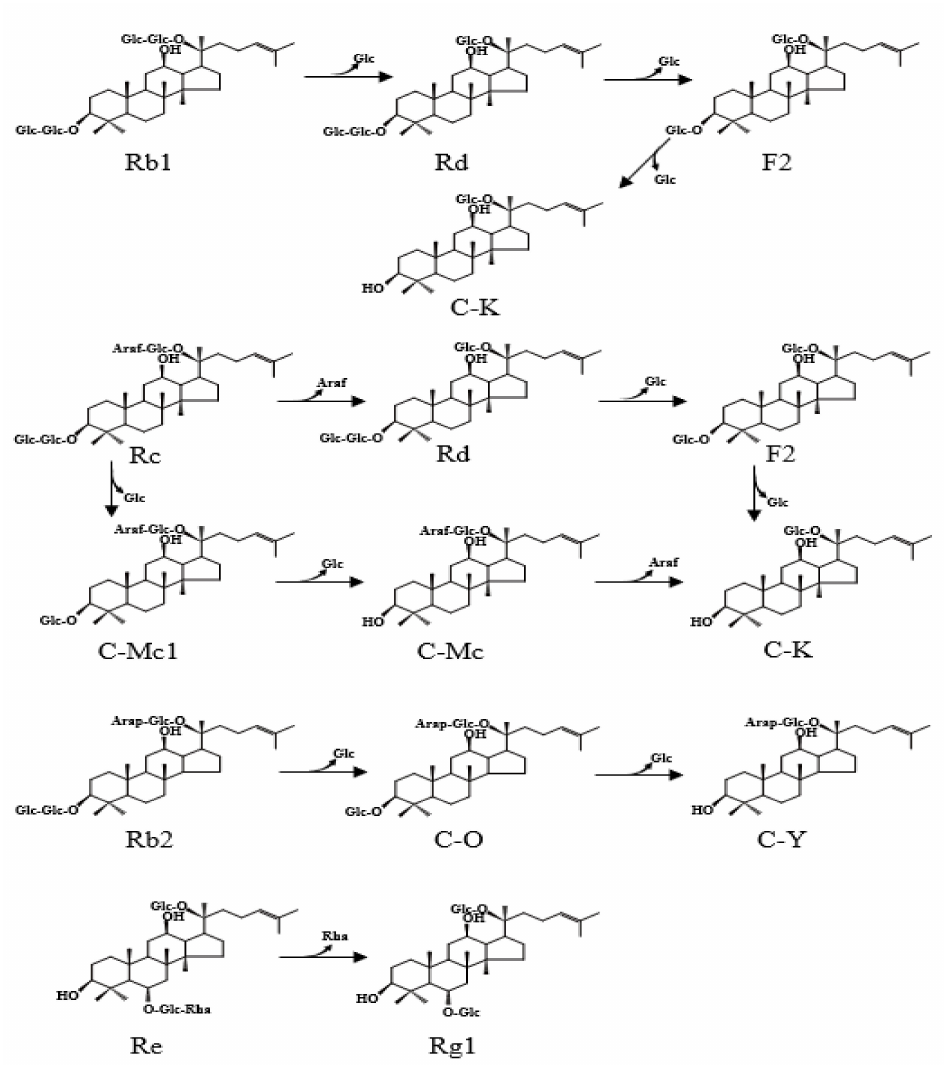
Figure 7. Proposed biotransformation pathways of major ginsenosides by FFEP. The preference in biotransformation pathways of PPD-type ginsenosides also depends on microbial sources. Biotransformation of Rb1 into C-K can occur through pathways of two types, depending on its structure. One pathway is through hydrolysis of β -(1 → 6)- glucosyl moiety at the C-20 position and β -(1 → 2)-glucosyl moiety at the C-3 of aglycone for the formation and Rd and F2 as the intermediates. Another one is by sequentially hy- drolyzing the β -(1 → 2)-glucosyl (outer) and β -glucosyl moieties (inner) at the C-3 position of aglycone for the formation of gypenoside XVII and gypenoside LXXV as the intermedi- ates. Microbial β -glucosidases from Fusodobacterium K-10, Paecilomyces bainier , Sulfolobus solfataricusm , Cladosporium fulvum and Aspergillus oryzae transformed ginsenoside Rb1 into C-K through the pathway of Rb1 → Rd → F2 → C-K, while Terrabacter ginsenosidimutans performed the transformation via the Rb1 → gypenoside XVII → gypenoside LXXV → C-K pathway [21,26]. Ginsenoside Rc can also be hydrolyzed via multiple pathways by microbial β -glucosidases. The results from the present study show that biotransformation of ginsenoside Rc by FFEP occurred through two pathways, as presented in Figure 7. First, FFEP hydrolyzed the α -(1 → 6)-arabinofuranosidic linkage (outer) linked to the C-20 posi- tion of the aglycone to produce Rd from Rc, followed by hydrolysis of β -(1 → 2)-glucosidic (outer) and β -glucosidic (inner) linkages linked to the C-3 position to produce C-K. At the same time, this enzyme preparation hydrolyzed β -(1 → 2)-glucosidic (outer) and